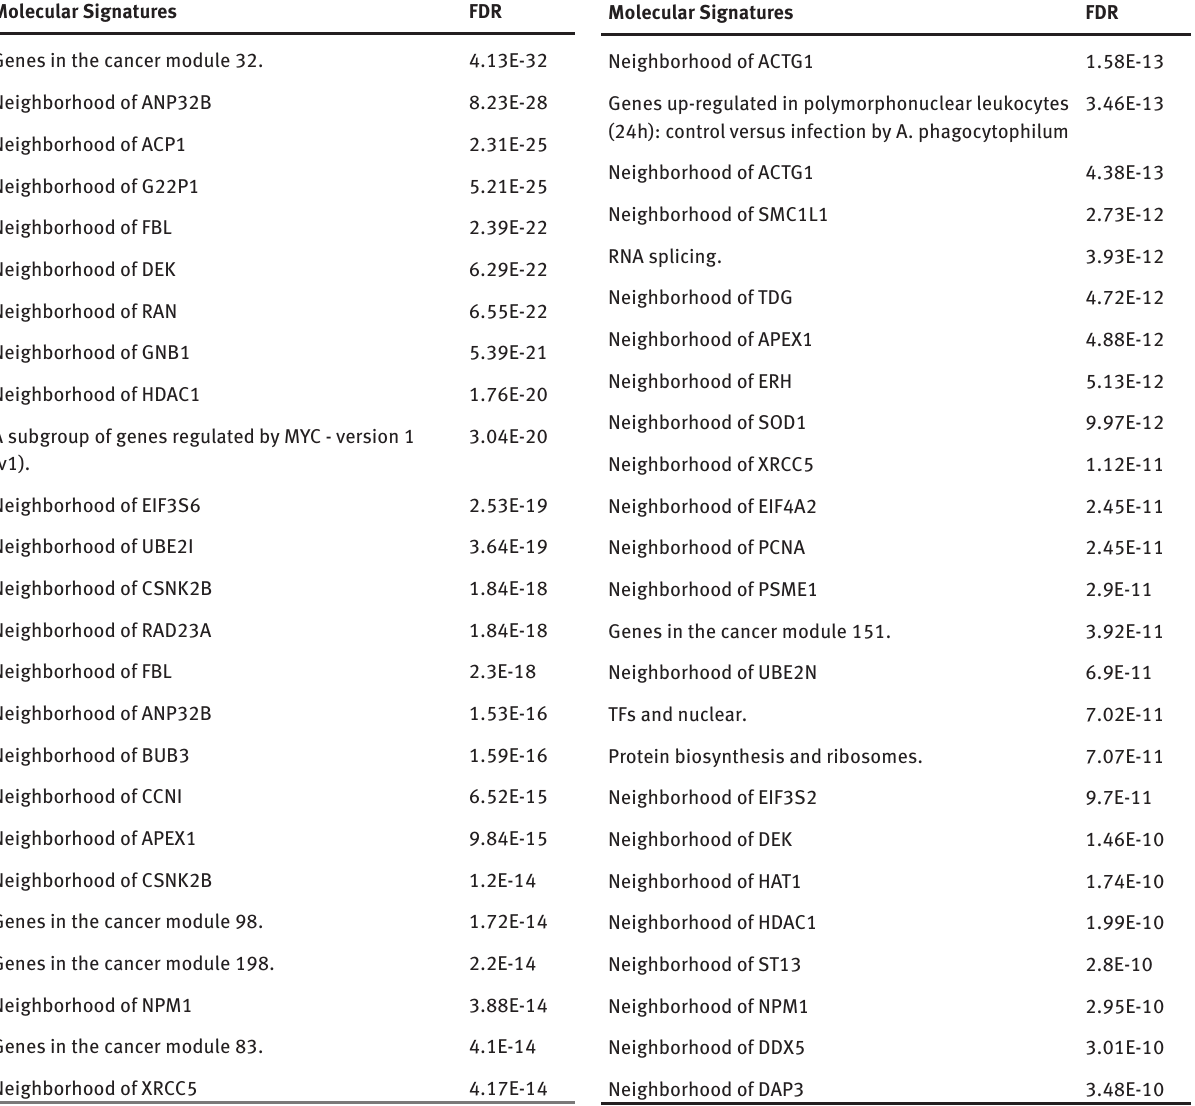
Table 2: The 50 most significantly enriched molecular signatures determined by the MSigDB molecular signature enrichment analysis. The name of the molecular signatures is provided, along with their False Discovery Rate (FDR) as computed by GSEA.